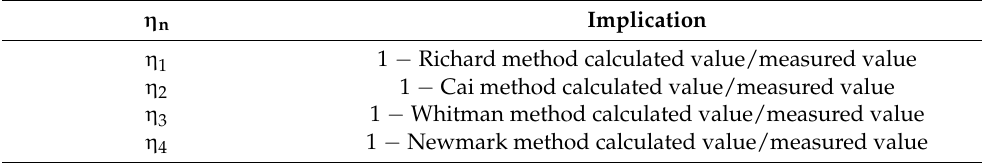
Table 6. Description of the